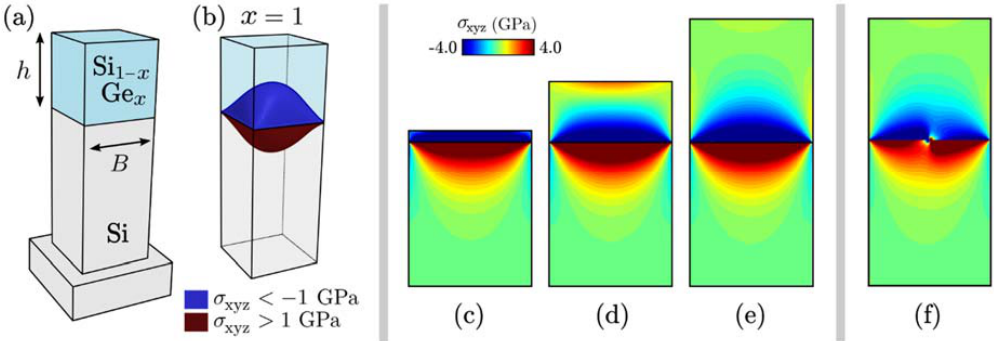
Figure 7. Theoretical modeling of VHEs and stress fields. ( a ) Simplified geometry of VHEs used to perform the theoretical analysis. ( b ) Illustrative map of the hydrostatic stress σ xyz in a VHE as in panel ( a ) with x = 1. ( c – e ) σ xyz in the central slice of a coherent 3D VHE as in panel ( a , b ) with an aspect-ratio R = h/B equal to 0.1, 0.5 and 1.0 respectively. ( f ) σ xyz as in panel ( e ) superposed to the hydrostatic stress field induced by a dislocation lying at the interface ( B = 25 nm). Reproduced with permission from [35]. American Institute of Physics.